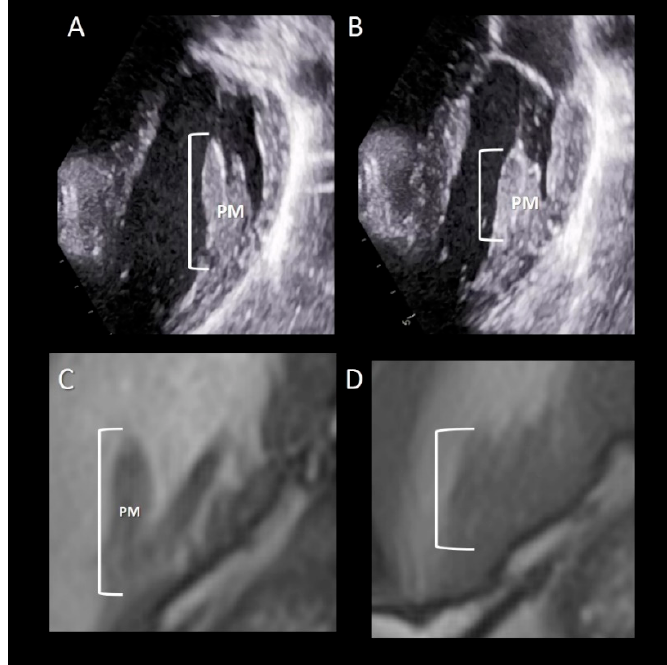
Figure 8. ( A , B ) 2D TTE and ( C , D ) CMR cross-sections in diastole ( A , C ) and in systole ( B , D ) showing the longitudinal contraction of papillary muscle (PM) preventing leaflet eversion during the systole (see text).